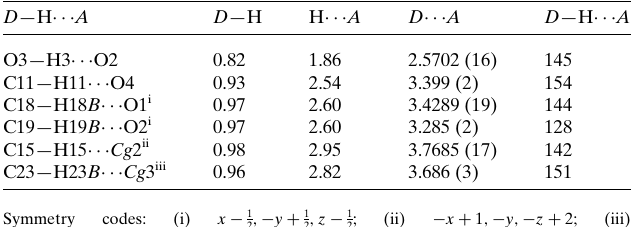
Table 1 Hydrogen-bond geometry (A˚ , (cid:2) ). Cg 2 and Cg 3 are the centroids of the C1–C6 and C7–C12 rings, respectively. D —H (cid:3)(cid:3)(cid:3) A